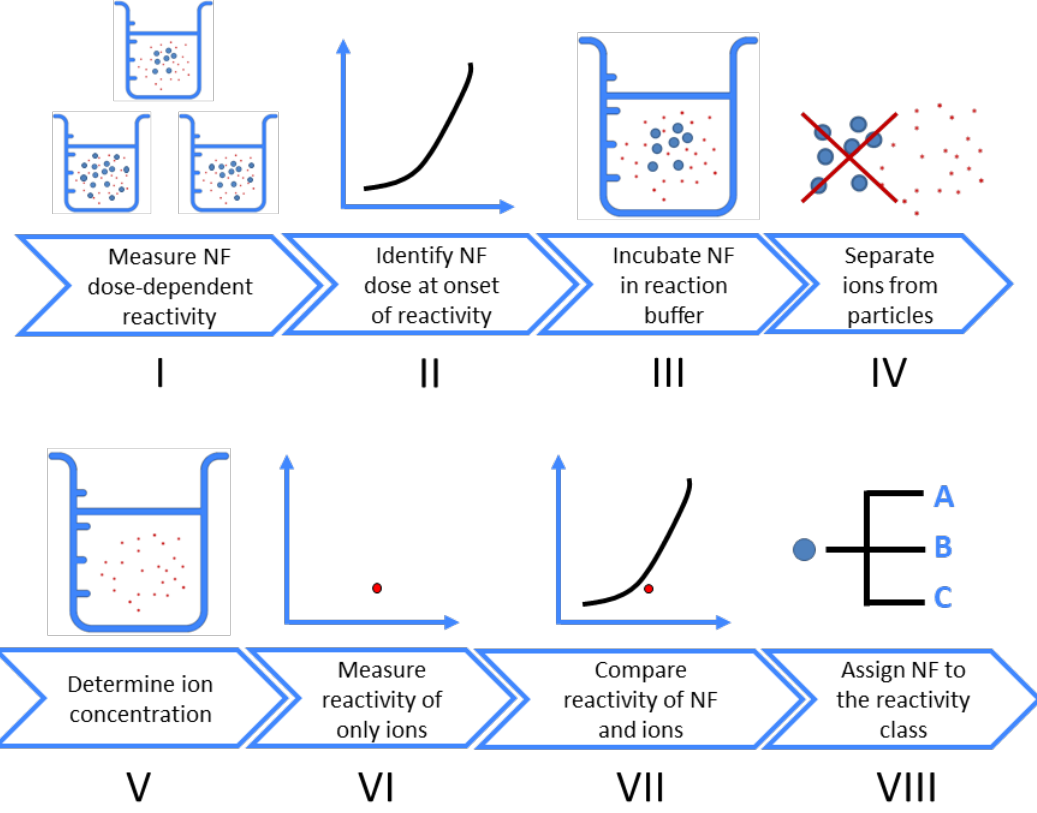
Figure 1. Stepwise workflow to assess whether ions contribute to dose-response curves of nanoform (NF) oxidative potential.